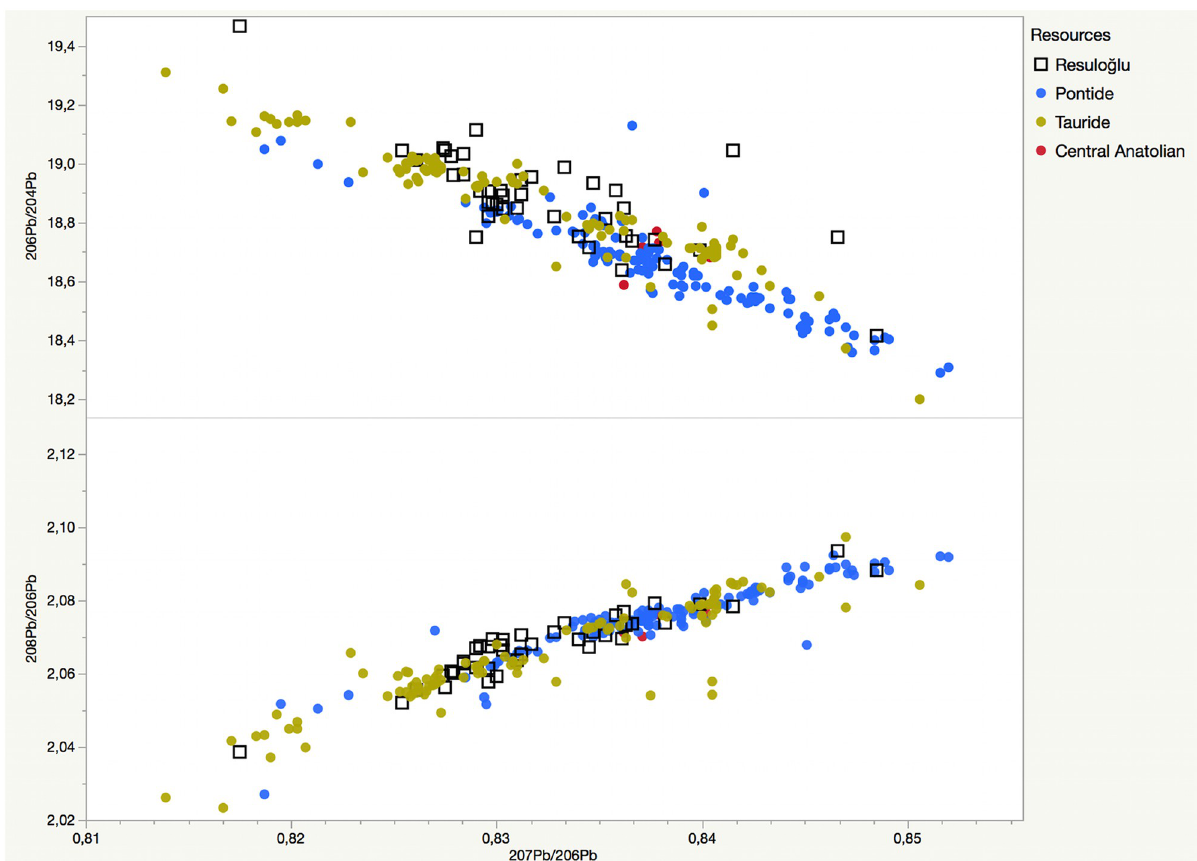
Fig 11. Lead isotope ratio binary graphs displaying 207 Pb/ 206 Pb vs. 208 Pb/ 206 Pb and 206 Pb/ 204 Pb of analyzed Resulo ğ lu metal samples compared to the published ore data from the Tauride and Pontide, and central